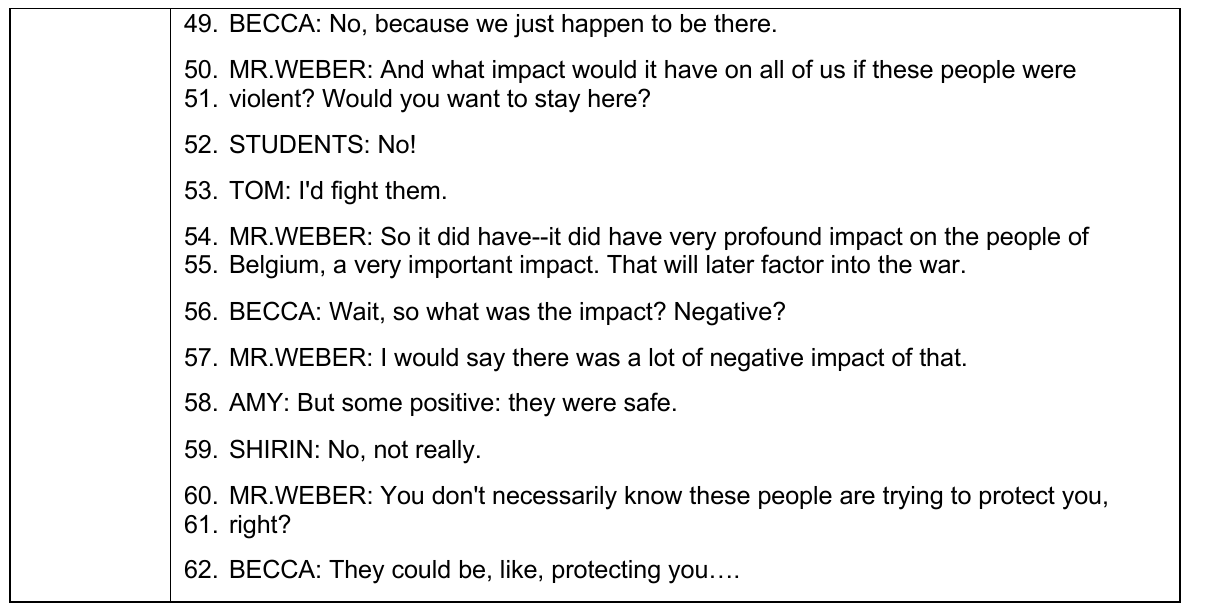
Figure 1. Reframing of the WWI homework review activity; progression from darker to lighter shading corresponds with shifts from recitation to dialogic, whole-class